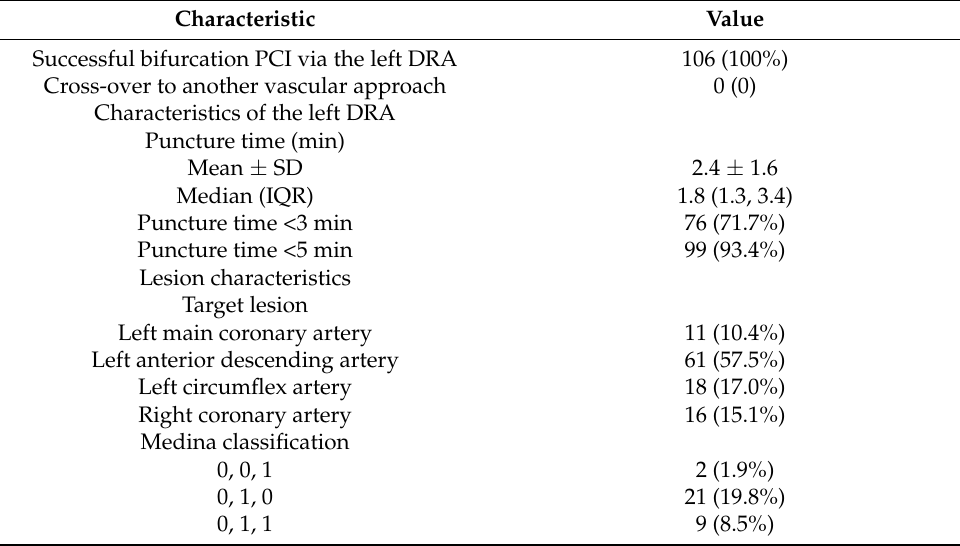
Table 2. Angiographic and procedural characteristics ( n =